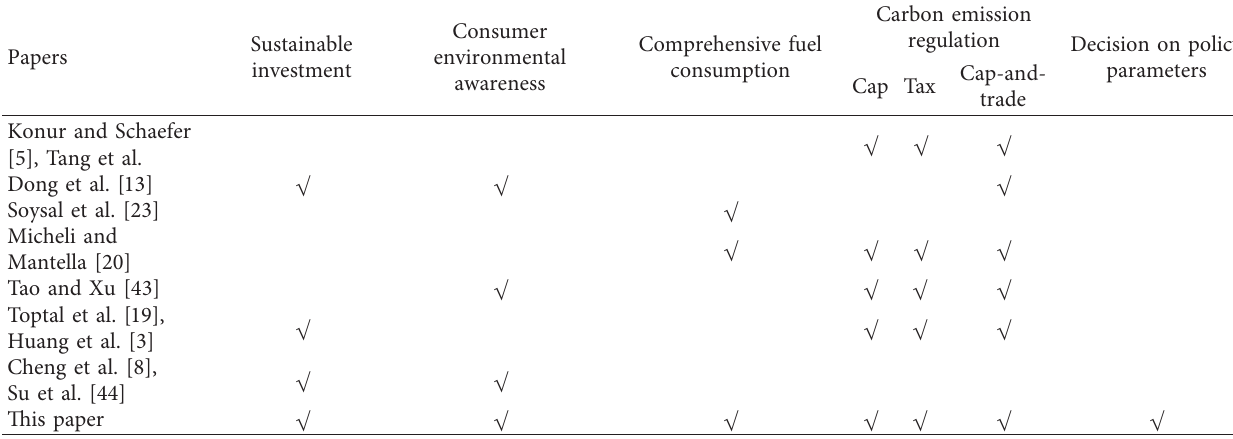
Table 1: The literature positioning of this paper.